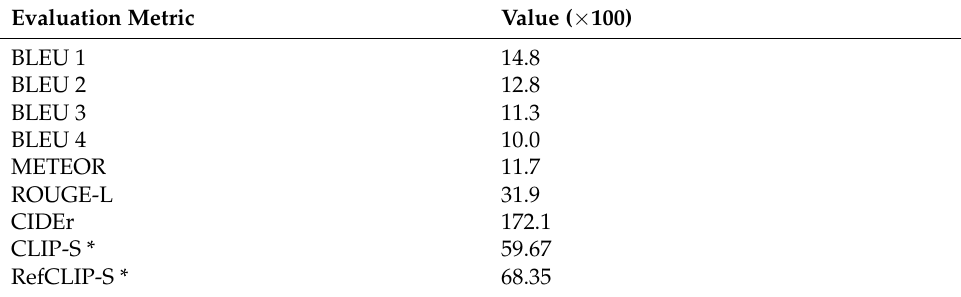
Table 1. Values of the evaluation metrics used for assessing the performance of the iconographic on a subset of the test